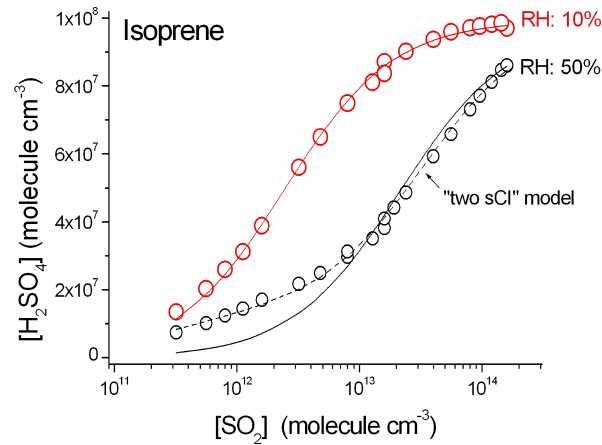
Figure 1. Loss-corrected measured [H 2 SO 4 ] at the outflow of IfT- LFT in α -pinene experiments at RH = 10% and RH = 50%. Lines show multivariate least-squares fittings according to Eq. (3), from which the relative rate coefficients and sCI yield were obtained.